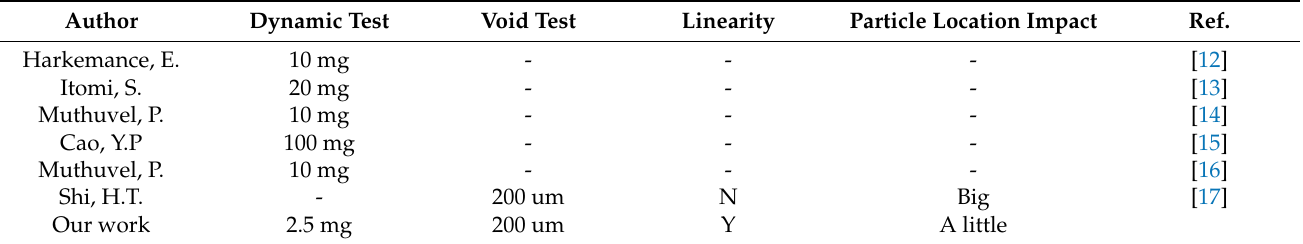
Table 3. Comparison of key technical parameters with other magnetic plug